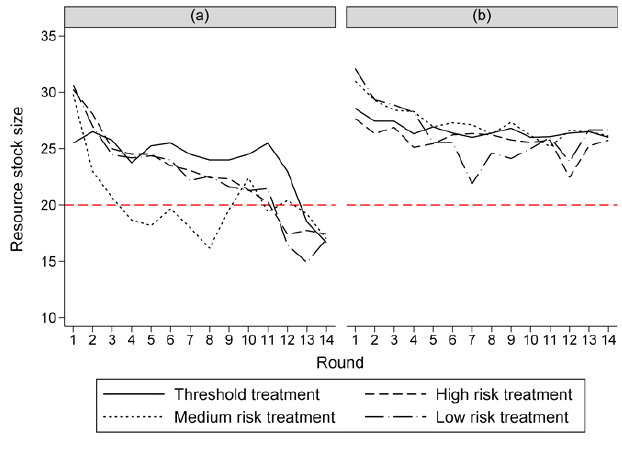
Fig. 5 . Comparison of average resource stock size after harvest over time between all four treatments for noncooperative groups (a) (N = 4 for threshold treatment; N = 11 for high-risk treatment; N = 6 for medium-risk treatment; N = 10 for low- risk treatment) and cooperative groups (b) (N = 16 for threshold treatment; N = 9 for high-risk treatment; N = 17 for medium-risk treatment; N = 9 for low-risk treatment). Data points below the red dashed line (potential threshold) indicate severe overexploitation. Data points between a resource stock size of 25 and 29 units indicate that in those rounds the groups achieved on average a regeneration rate of 9 units, the highest possible.